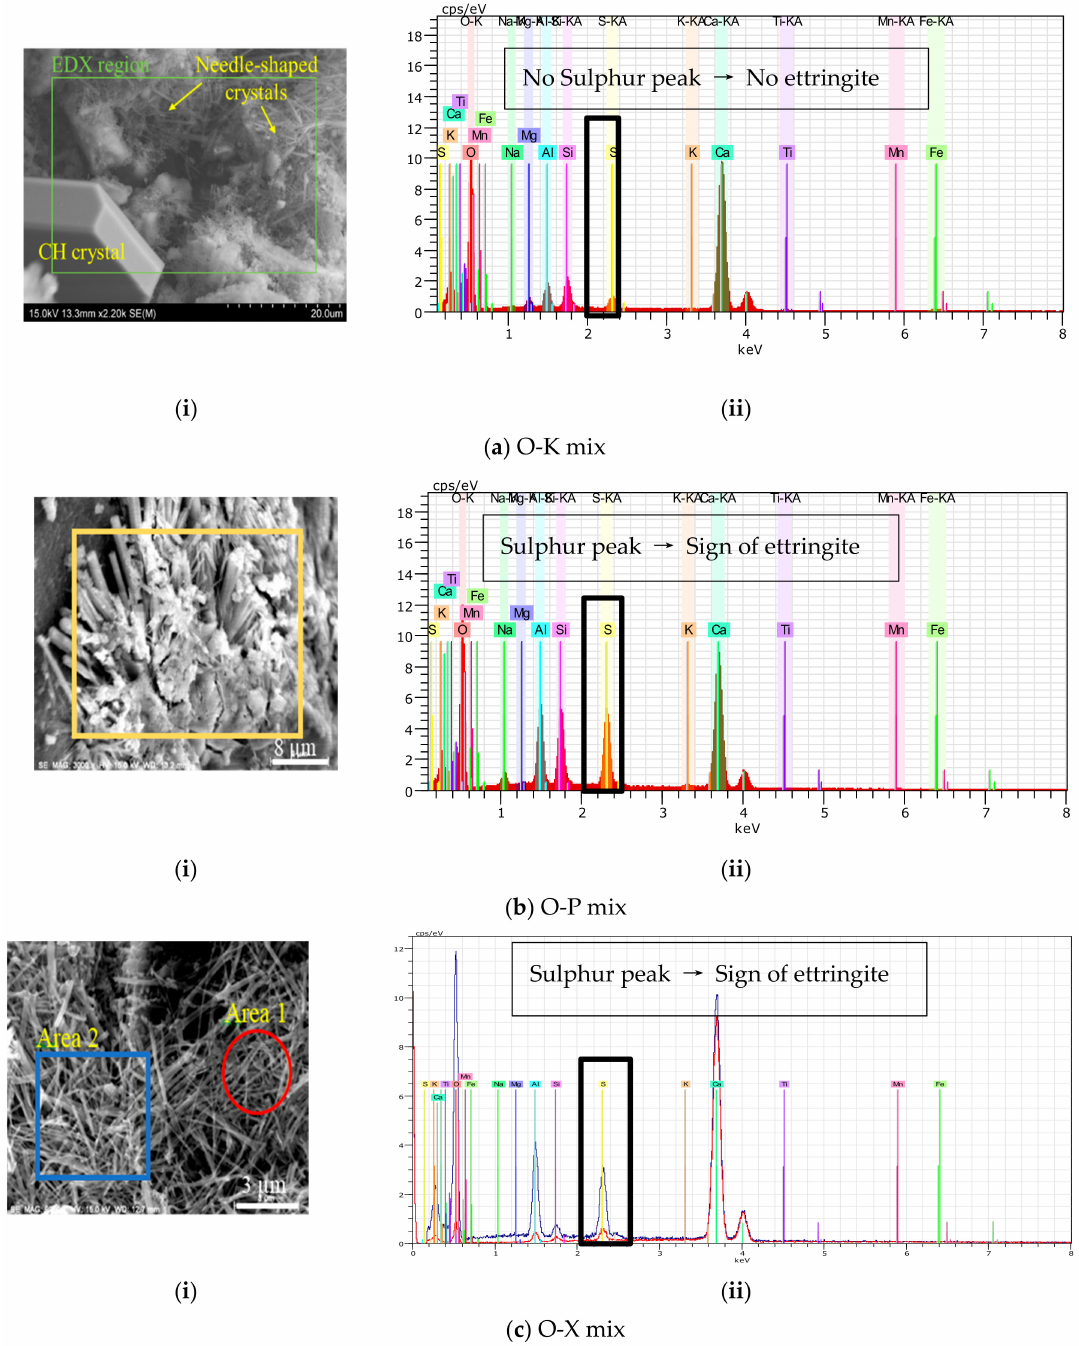
Figure 7. ( i ) SEM micrograph and ( ii ) EDS spectrum of cementitious composite CWA modified